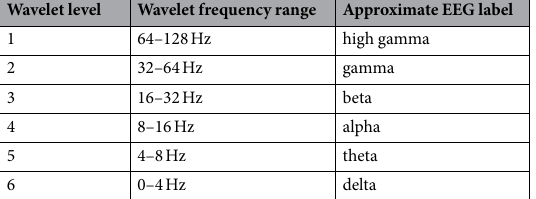
Table 2. Raw EEG signals are collected with a sampling rate of 256 samples per second, then decomposed by powers of two into the frequency bands shown using a wavelet decomposition. The resulting frequency bands are approximately equivalent to the standard EEG frequency band